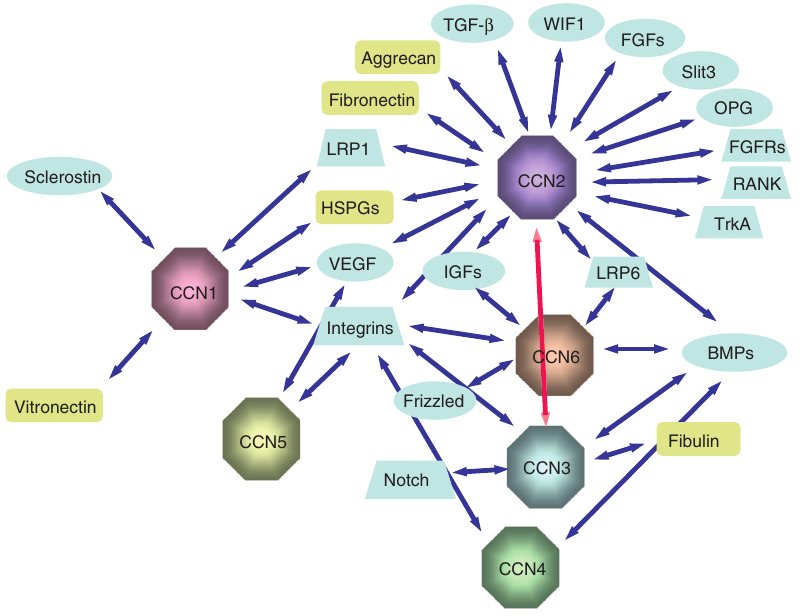
Figure 2 Interactomic representation of CCN family and cofactors. Direct binding between two molecules, as confirmed experimentally, is indicated by bidirectional arrows. Interaction between CCN2 and CCN3 is indicated as a red arrow to avoid